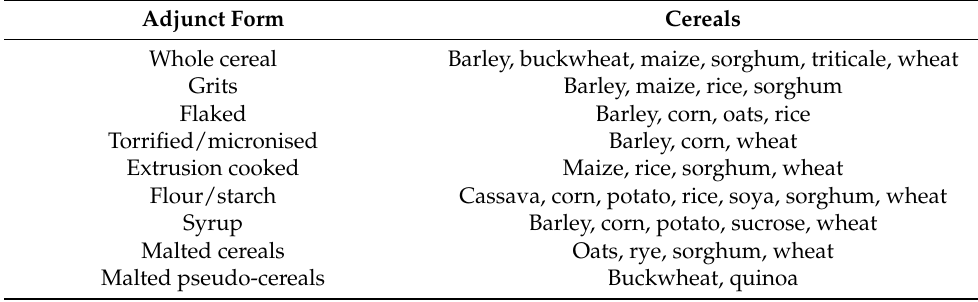
Table 1. Common brewing adjuncts available.